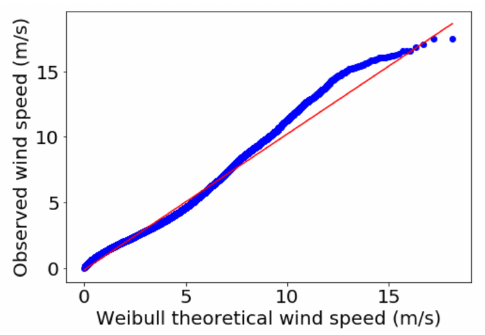
Figure 2. Probability plot of wind speed versus Weibull